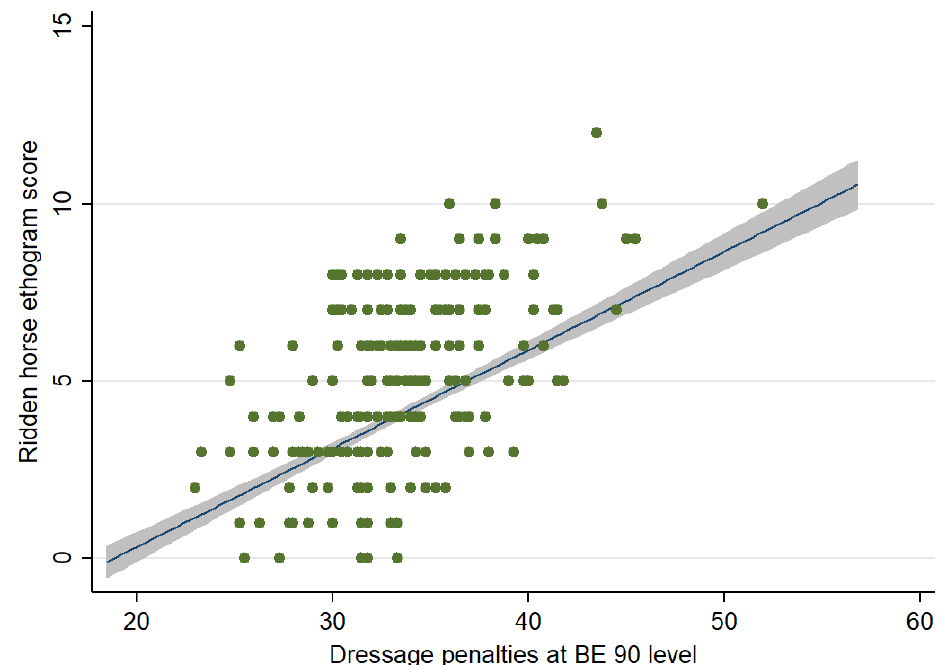
Figure 2. Relationship between the Ridden Horse Pain Ethogram (RHpE) scores and dressage penalty scores for competition starts at British Eventing 90 level ( n = 204). The green dots represent individual data points, the blue line is the best linear predicted fit and the grey area represents the corresponding 95% confidence interval. There was a moderate positive correlation (Spearman’s rho = 0.508, p < 0.001) between the RHpE scores and the dressage penalty